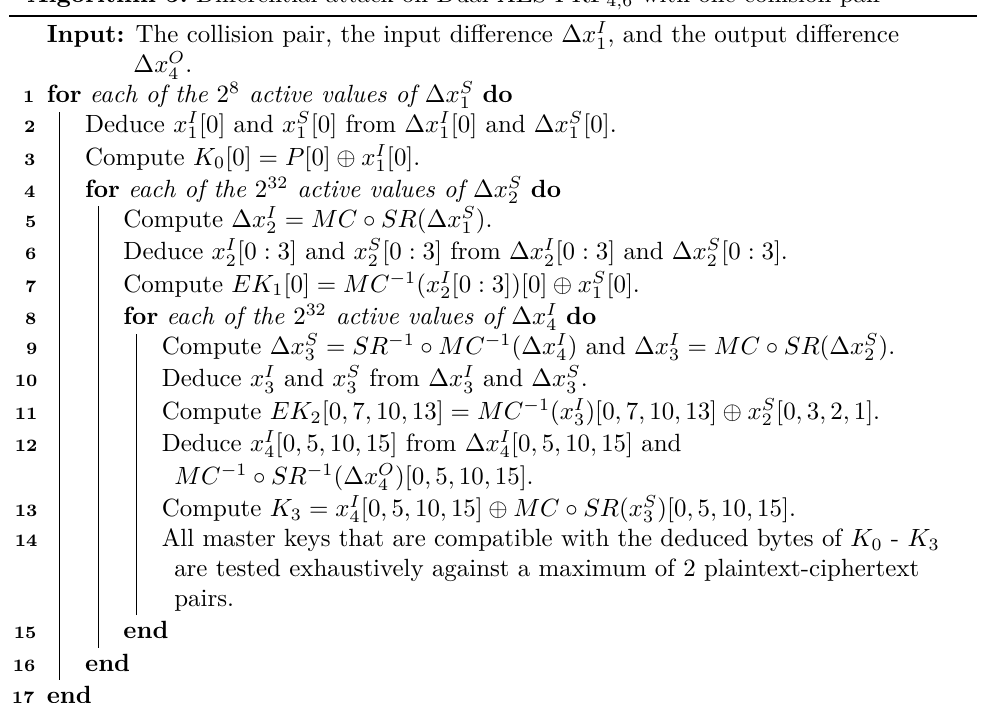
Algorithm 5: Differential attack on Dual-AES-PRF 4 , 6 with one collision